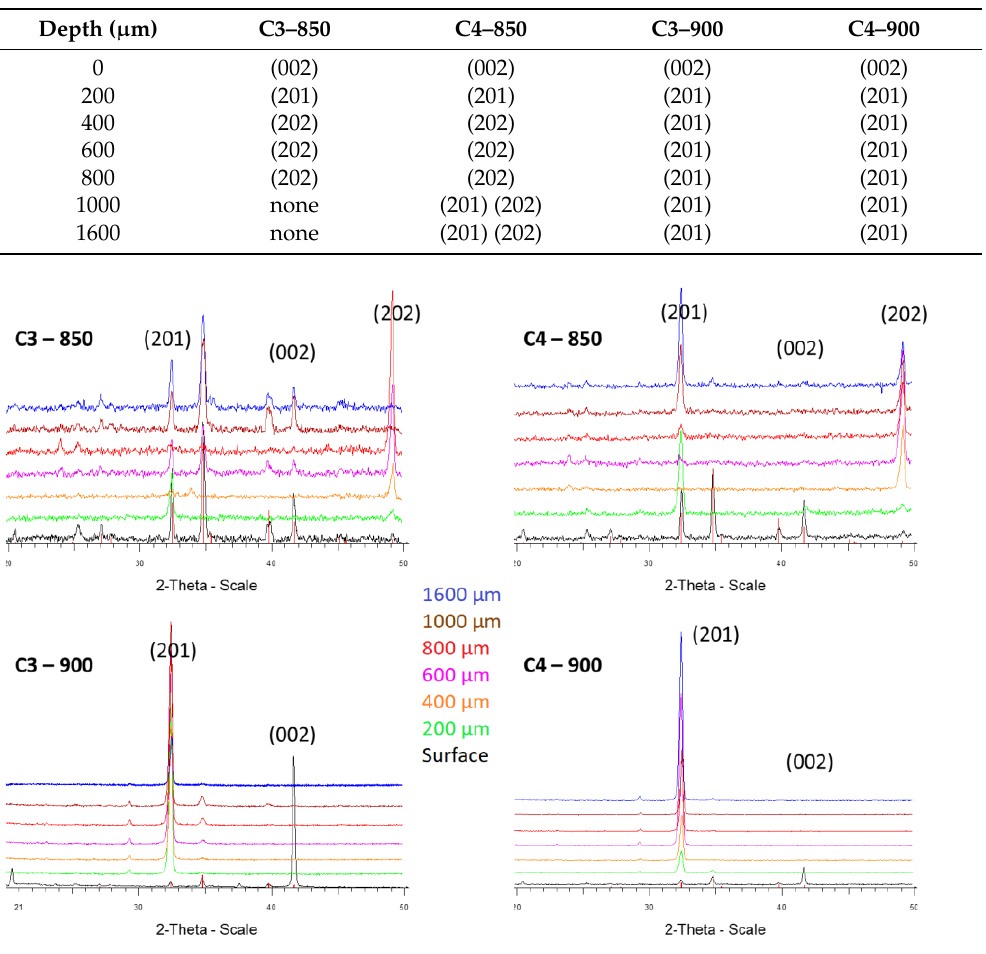
Figure 17. X-ray diffraction patterns of the glass-ceramics. Analyses of the surfaces and over depths by successive grinding steps.